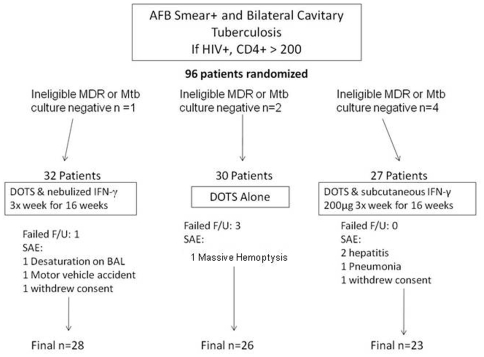
Flow Diagram showing number of study subjects screened, randomized to the three study groups n = 96, and who met inclusion criteria, n = 89).